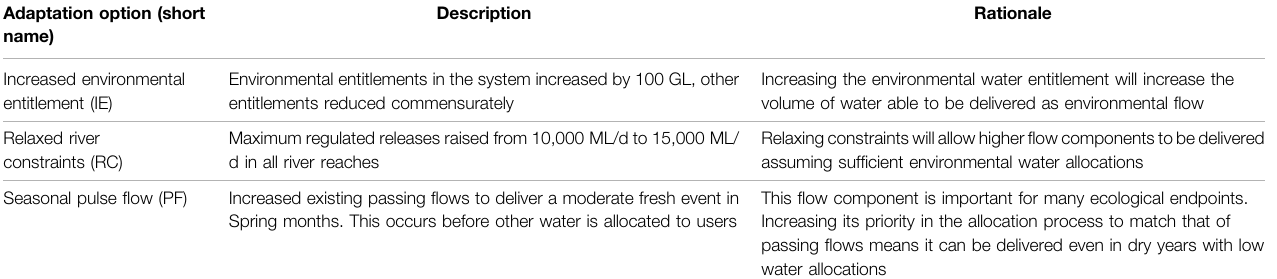
TABLE 3 | Summary of different adaptation options trialed in this study. Options are modelled individually and in all combinations.